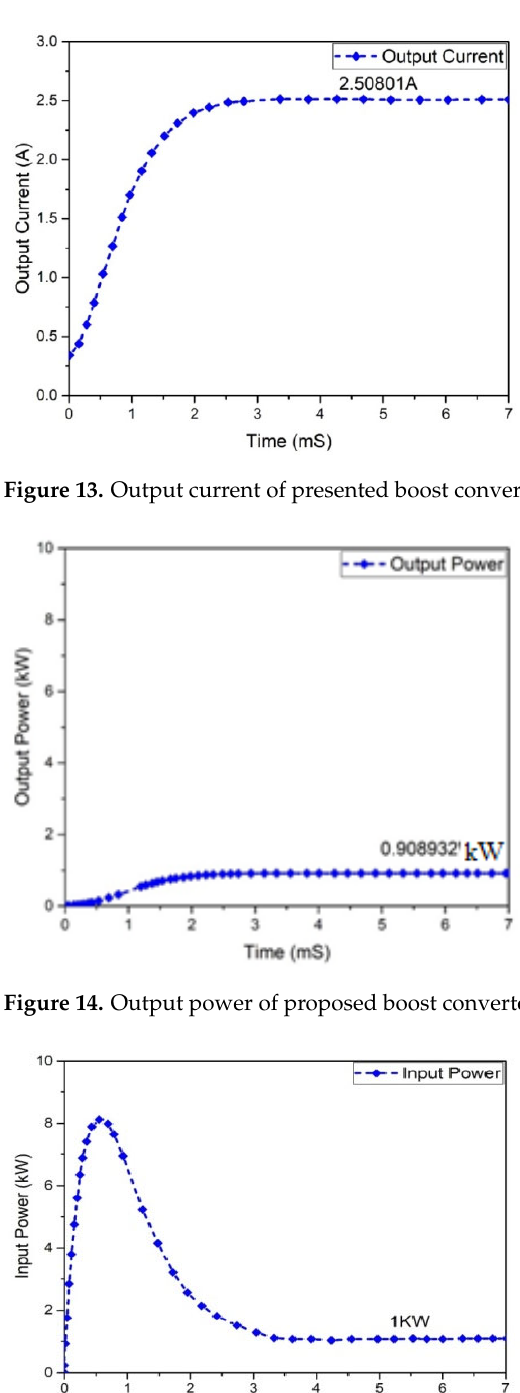
Figure 12. Boost converter output voltage.